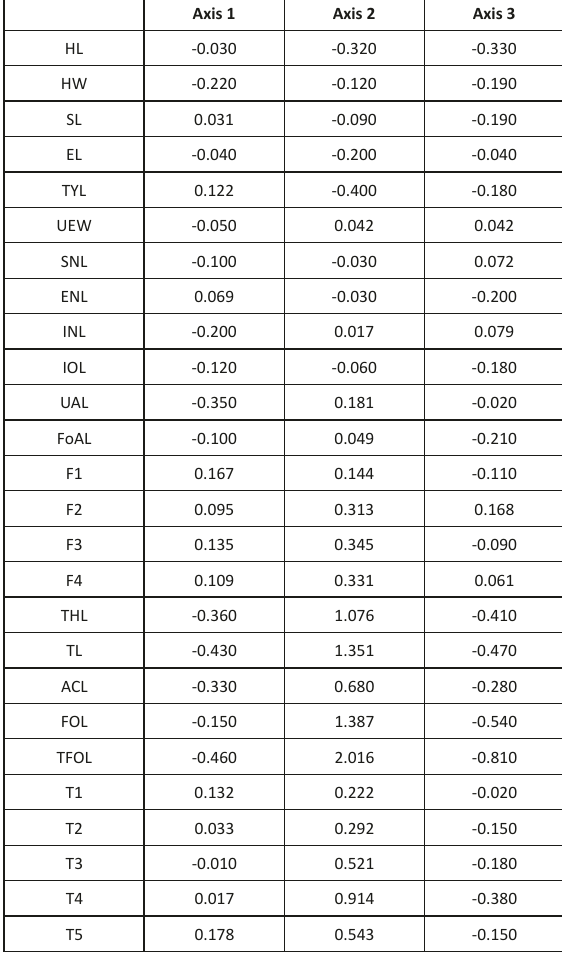
Table 3. CVA loadings of morphometric characters on the first three canonical axis.